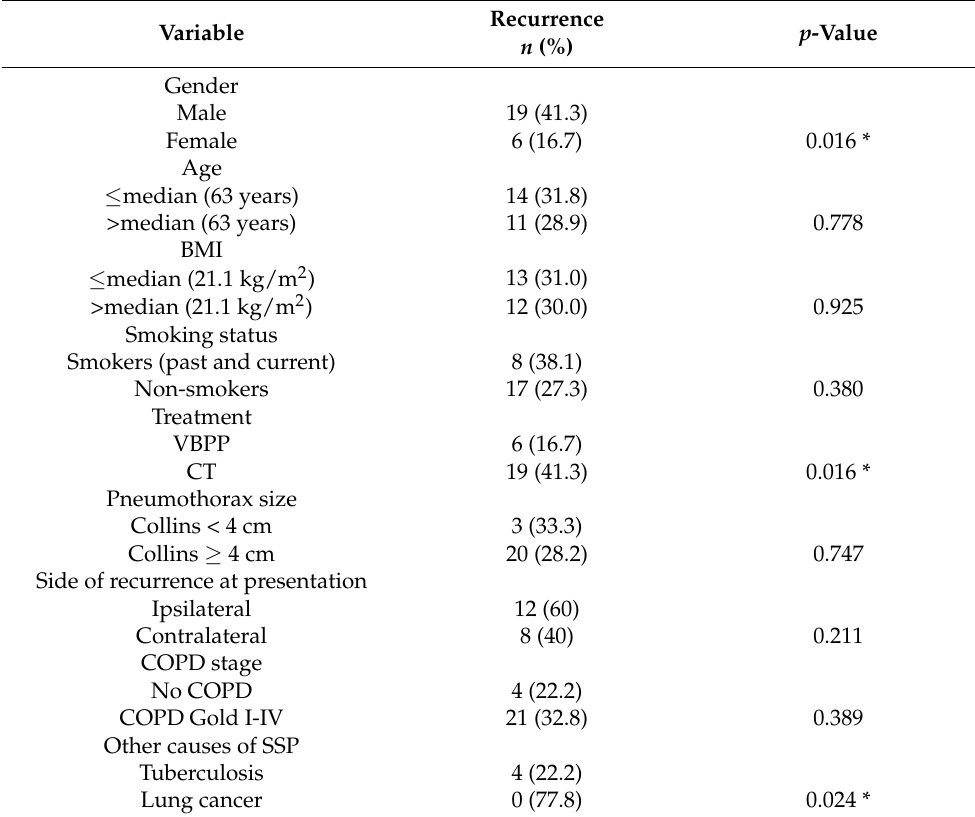
Table 2. Patient clinical characteristics and recurrence rates of